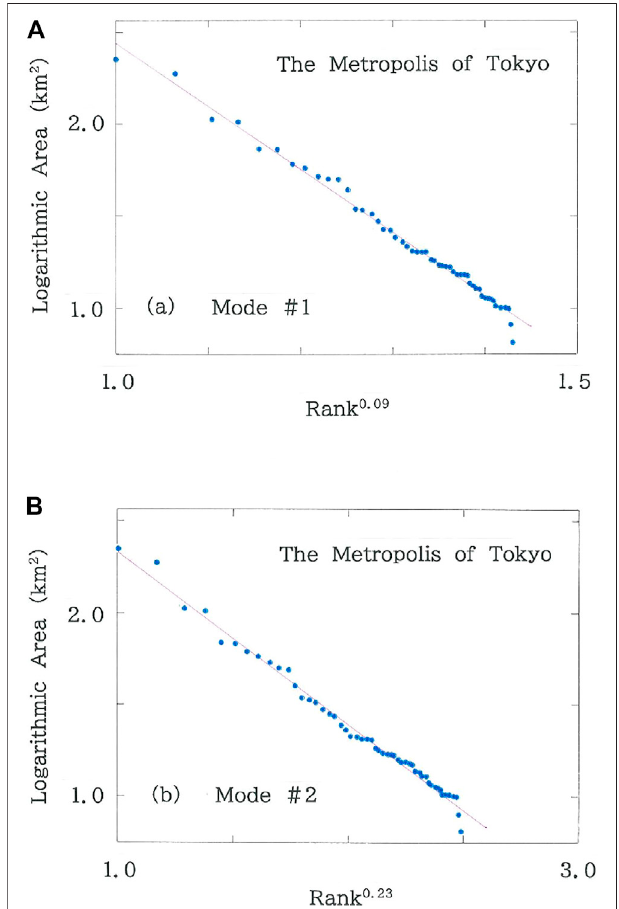
FIGURE9| StretchedexponentialityfortheMetropolisofTokyo( n (cid:1) 53). (A) Mode#1( q (cid:1) 0.09;| r | (cid:1) 0.9948with d (cid:1) 2.002). (B) Mode#2( q (cid:1) 0.23;| r | (cid:1) 0.9953 with d (cid:1)